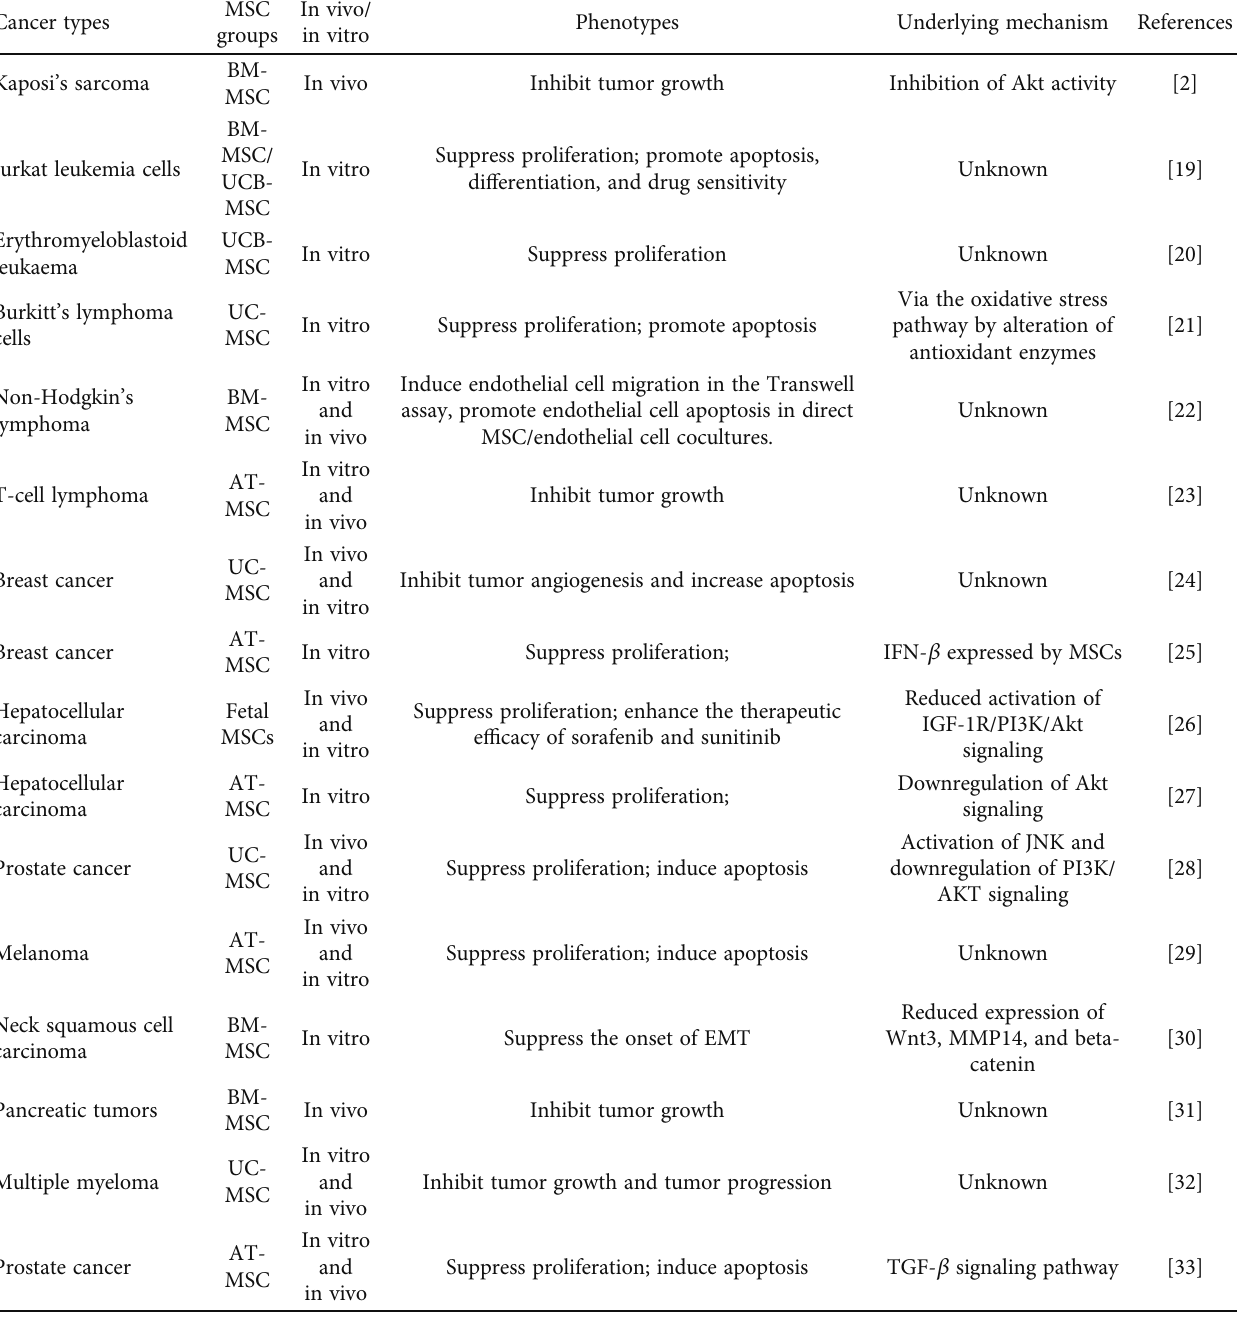
Table 1: The antitumorigenic activity and mechanism of MSCs on